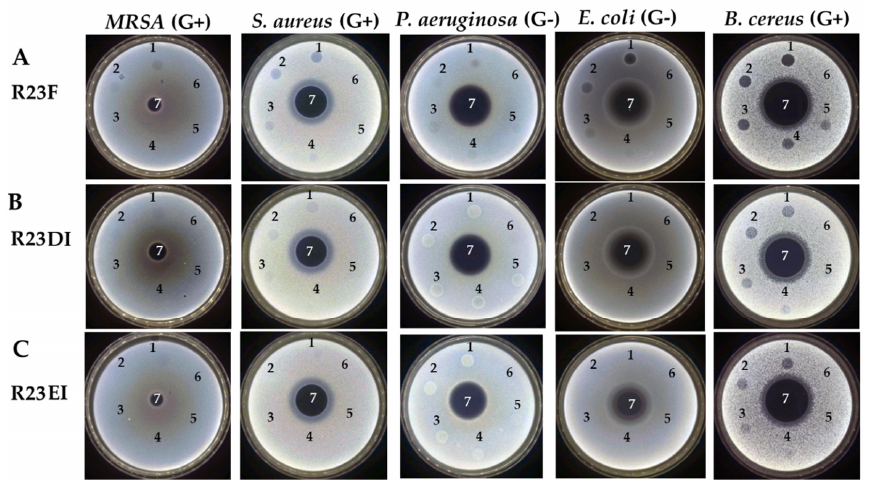
Figure 4. Results of testing the antimicrobial effects of peptides R23F, R23DI, R23EI against MRSA (Gram-positive, G+), S. aureus (Gram-positive, G+), P. aeruginosa (Gram-negative, G − ), E. coli (Gram- negative, G − ), and B. cereus (Gram-positive, G+) . Bacteria were grown on solid agar medium LB. Application scheme: 1—peptide 300 μ M; 2—peptide 150 μ M; 3—peptide 75 μ M; 4—peptide 37.5 μ M; 5—peptide 18.75 μ M; 6—LB with DMSO 2% ( v / v ); 7—gentamicin sulfate 1700 μ M. B. cereus cells were found to be the most sensitive to peptides. Thus, for the R23F, R23DI, and R23EI peptides, the value of the minimum inhibitory concentration (MIC) was 75 μ M, 150 μ M, and 300 μ M, respectively. Among the individual peptides, the highest antibacterial activity was found for the R23F peptide (MIC was 300 μ M against S. aureus and E. coli ) and the lowest for R23EI (MIC ≥ 300 μ M against all using microorganisms). For the R23DI and R23EI peptides used against P. aeruginosa , more growth of strain cells was observed at the areas of peptide preparations. Perhaps, instead of suppressing the growth of P. aeruginosa bacterial cells, the opposite effect was observed. The least antibac- terial effect was in tests against MRSA (MIC ≥ 300 μ M for all testing peptides).